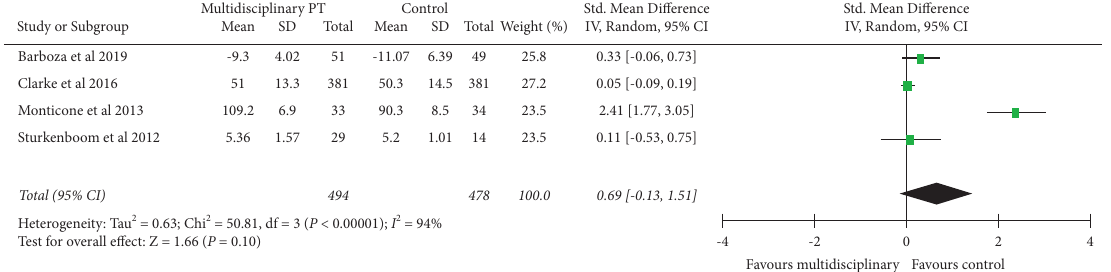
Figure 2: Forest plot multidisciplinary physiotherapy with the control group: functional mobility.